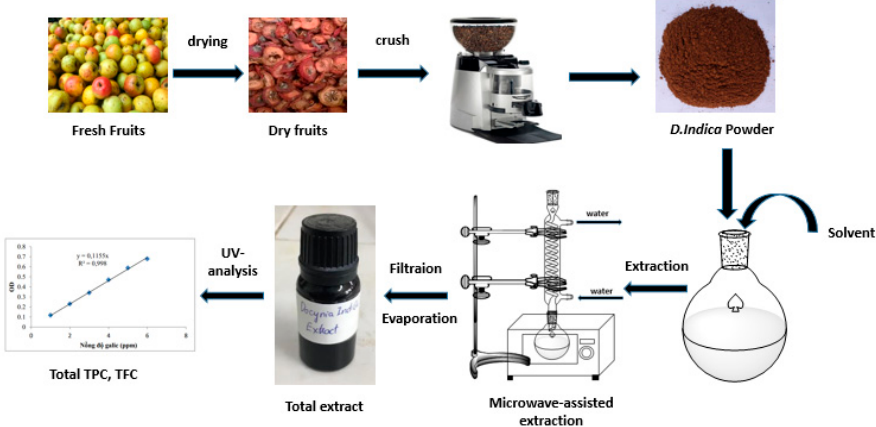
Figure 1. The process of the total phenolic and flavonoid extraction.